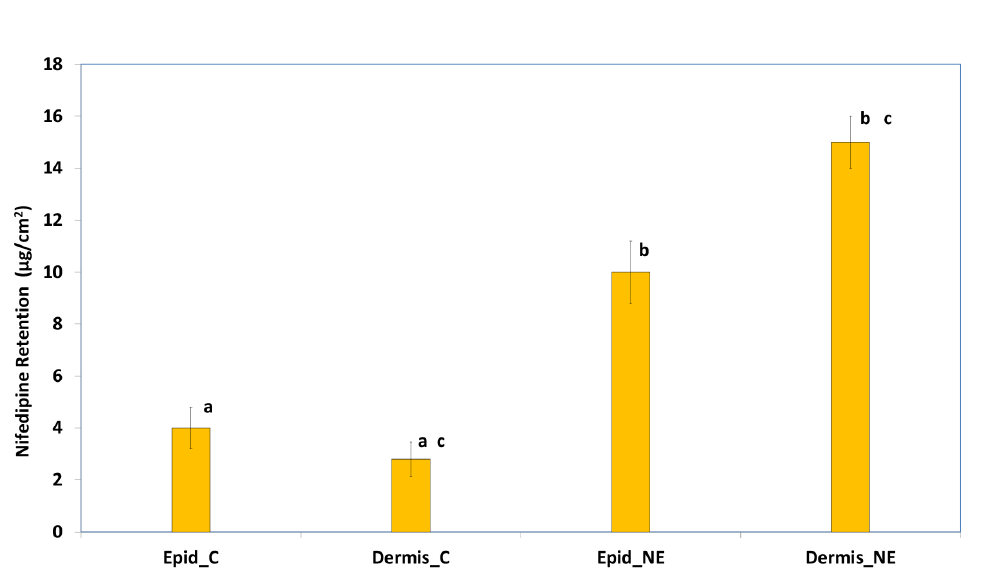
FIGURE 7 - Quantity of nifedipine retained in the epidermis or dermis after 4 hours of contact of the nanoemulsions with the skin. (a) None-statistically significant difference (p>0.05) between the drug quantity retained in the epidermis in relation to the dermis; (b) Statistically significant difference (p<0.05) between the drug quantity retained in the epidermis; (c) Statistically significant difference (p<0.05) between the drug quantity retained in the dermis. All the results are mean ± standard deviation of 6 measurements. C – Cream; NE –